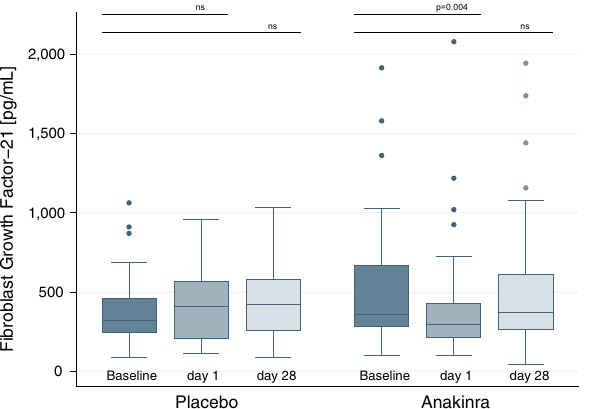
Figure 1. Box plots of FGF21 levels at baseline (dark blue) and after short-term treatment (medium blue) as well as after longer-term treatment (light blue) in patients randomized to placebo or anakinra from Trial B, respectively. P-values were determined using a linear mixed model. Each box signifies the upper and lower quartiles, while the median is represented by a line within the box. Whiskers represent the upper and lower adjacent values, outliers are depicted as dots.